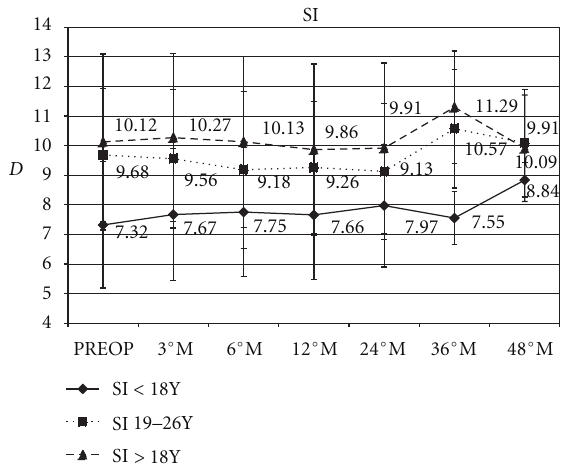
Figure 5: Graph showing topographic analysis of corneal symmetry using the superior-inferior index (SI). After cross-linking SI improved in paediatric patients by a mean of +0.3D, +0.6D, +0.2D and +1.5D; in the intermediate group changed by a mean of: − 0.42 D, − 0.55 D, +0.90D, +0.40 D; in adult patients varied by a mean of: − 0.26 D, − 0.21 D, +1.17D, − 0.21 D at 12, 24, 36 and 48 months of follow-up respectively.